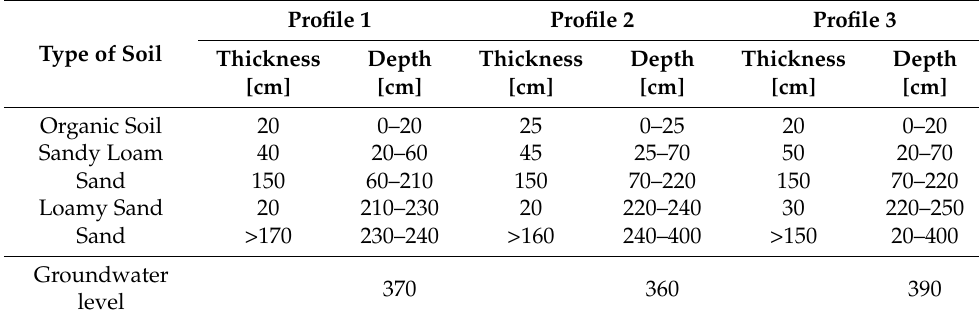
Table 2. Soil layers at the location of the infiltration facility.